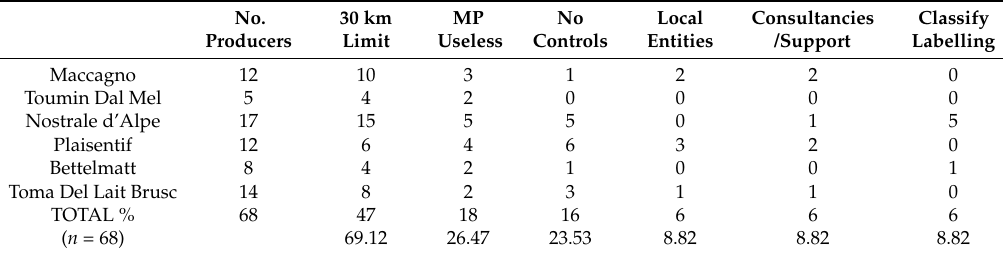
Table 3. The doubts involved in the OQT “mountain product” by the producers i.e., the derogation of 30 km, the scarce usefulness of OQT for small mountain farms, the lack of a regulated control system, the lack of local entities’ support, the lack of consultancy activities to access European funds, the lack of a classified labelling